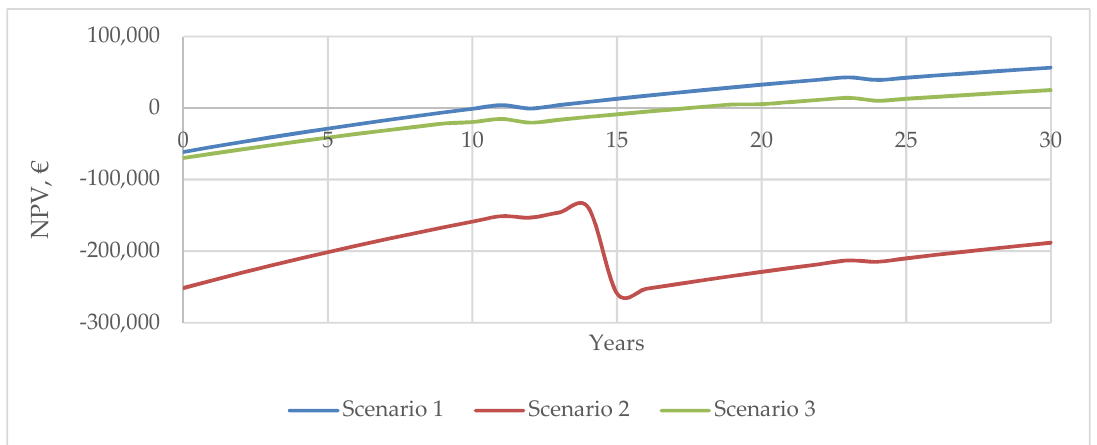
Figure 7. Discounted cumulative cash flows for 3 scenarios.